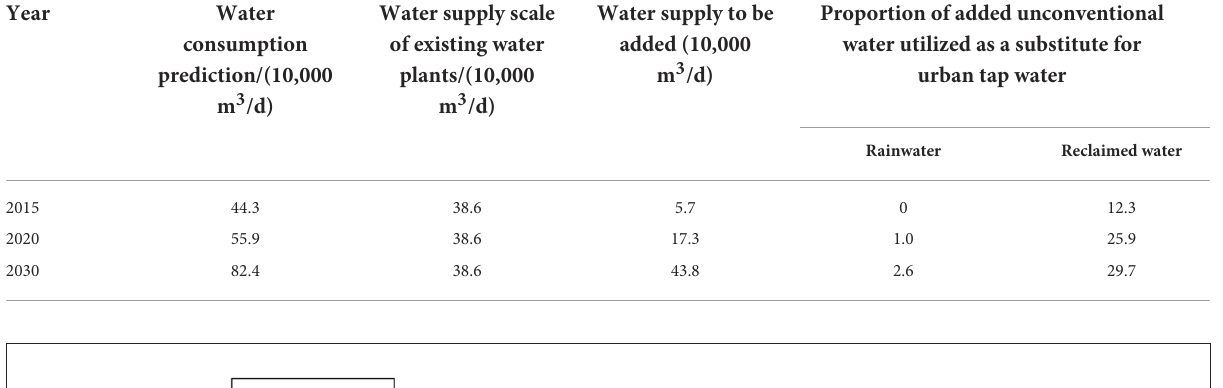
TABLE 4 Balance of water supply and demand in the central urban districts of Xining.